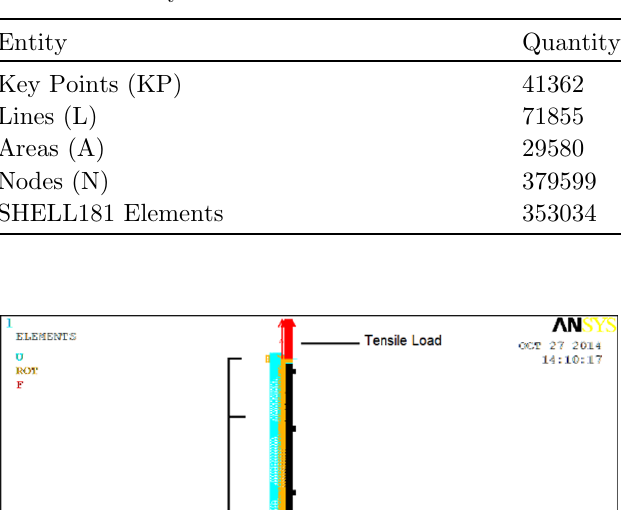
Table 1. Entity details of the FE model. Table 2. Material properties of grid & guide thimble.